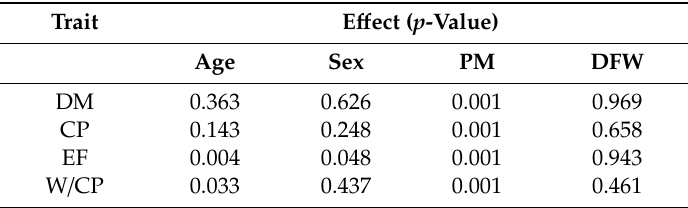
Table 7. The p -Values for the e ff ect of age, sex, point of measurement and carcass weight on the proximal chemical composition of meat and o ff al from the wild